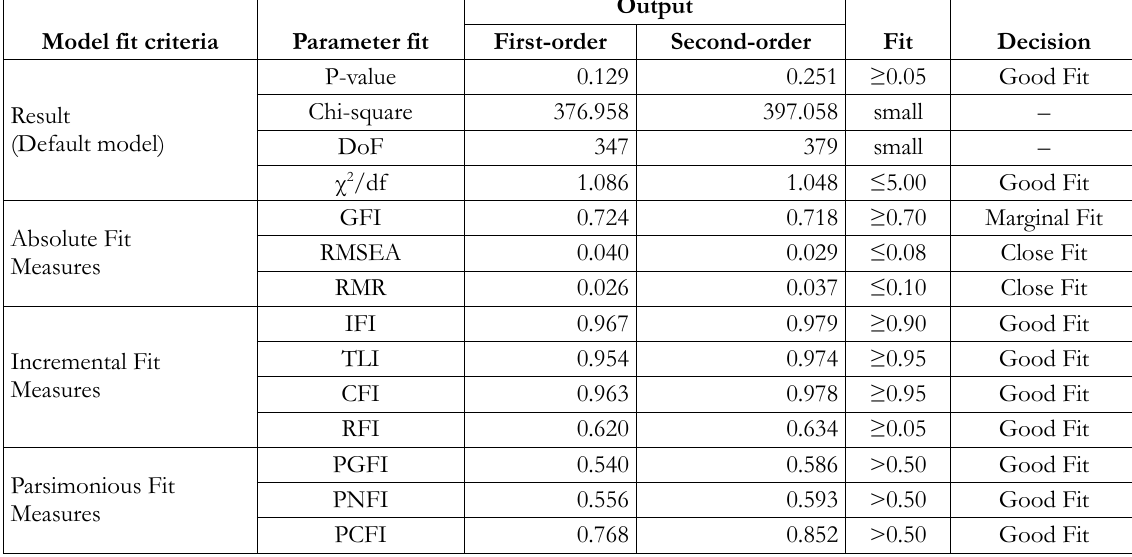
Table 5. Results of the Construct Model for Measuring Student Competency